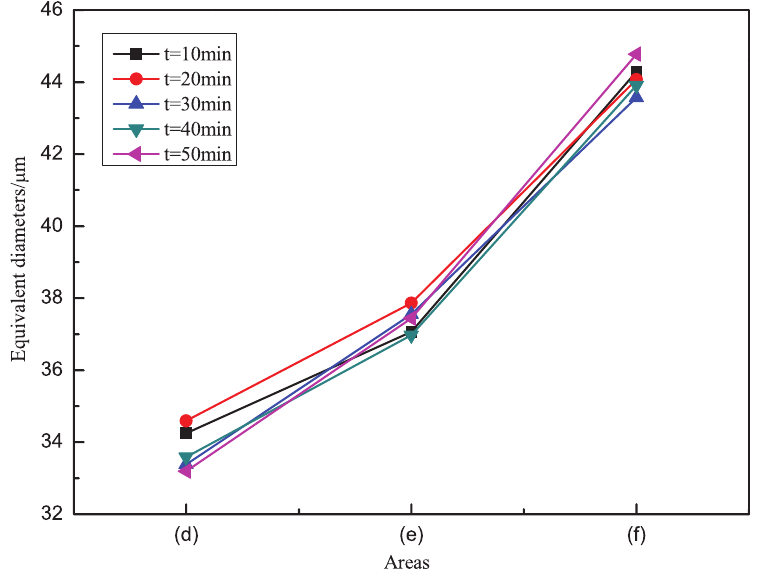
Fig. 7: Variations of equivalent diameters of V-containing spinel phase in different areas of the samples with different time at G = 1050, T = 1523 K.